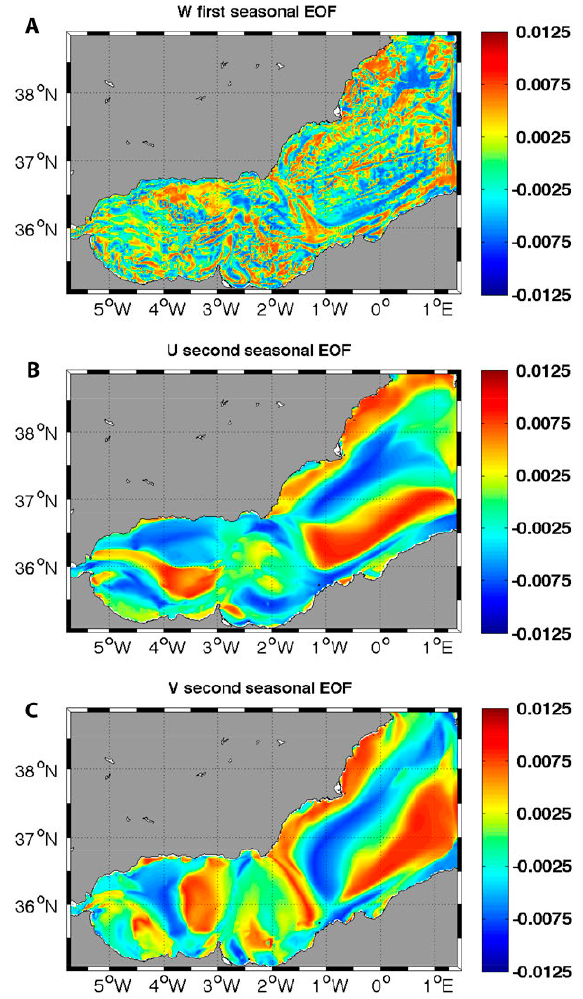
Fig. 5. – A, first EOFs of seasonal W; B, second EOFs of U; and C, second EOFs of V.